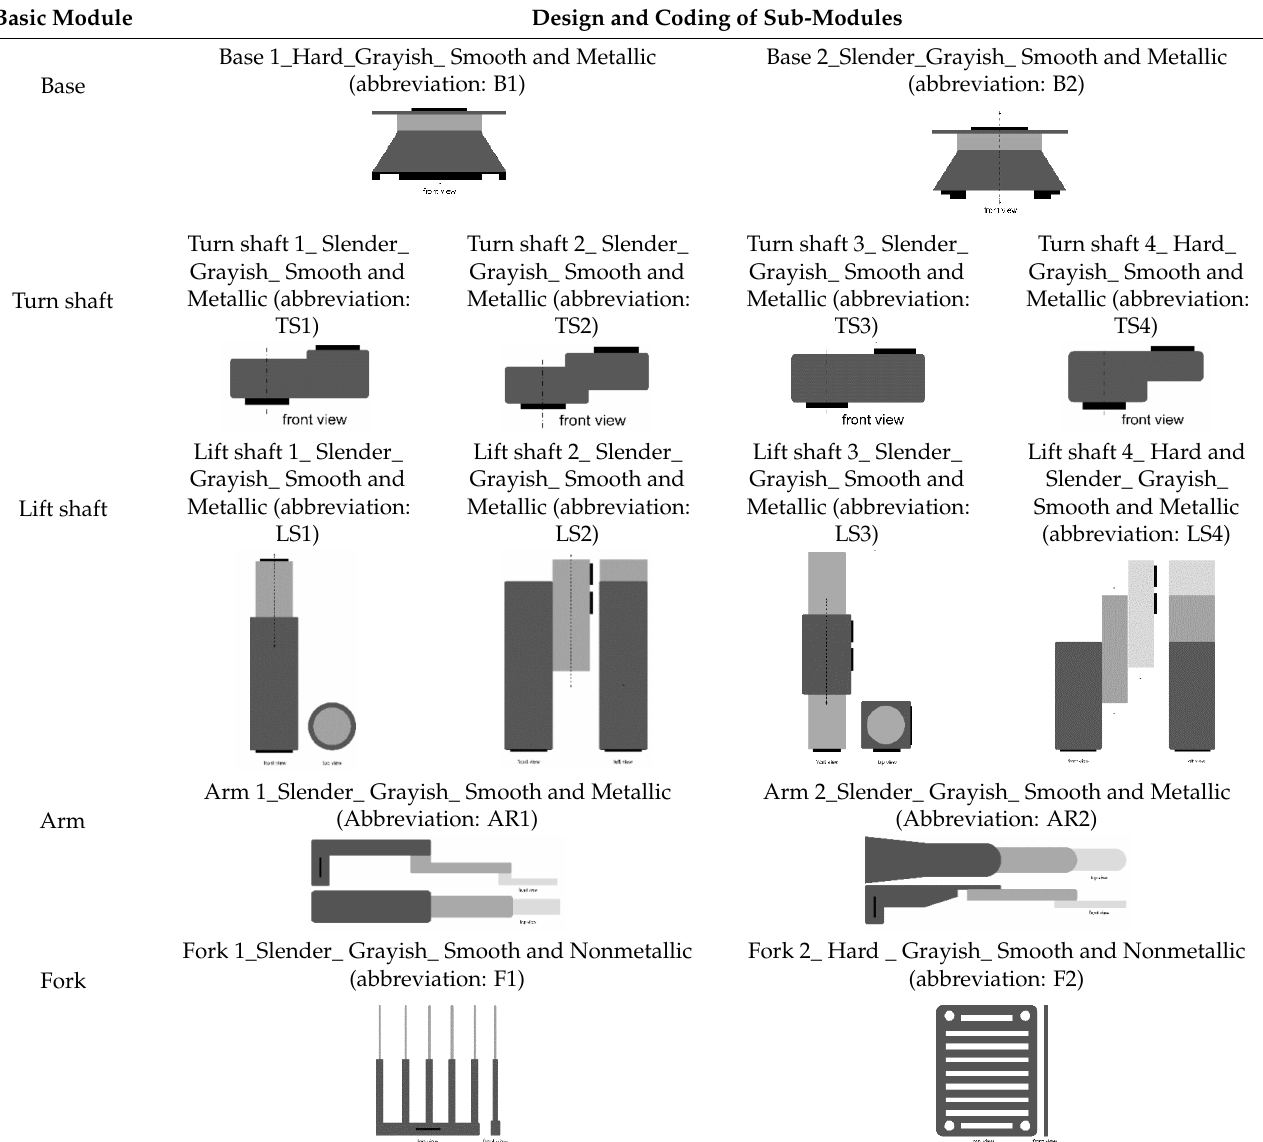
Figure 5. Module division of a glass substrate transfer robot. Table 4. Design and coding of the glass substrate transfer robot module.